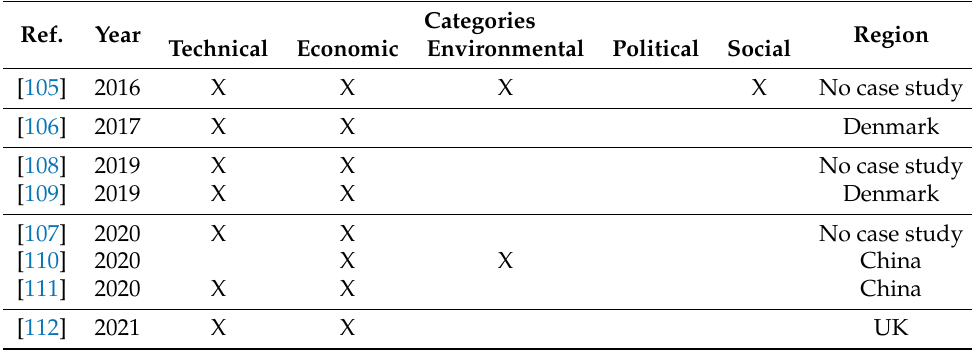
Table 4. Papers with offshore wind repowering methodologies. Period (2000–2021).